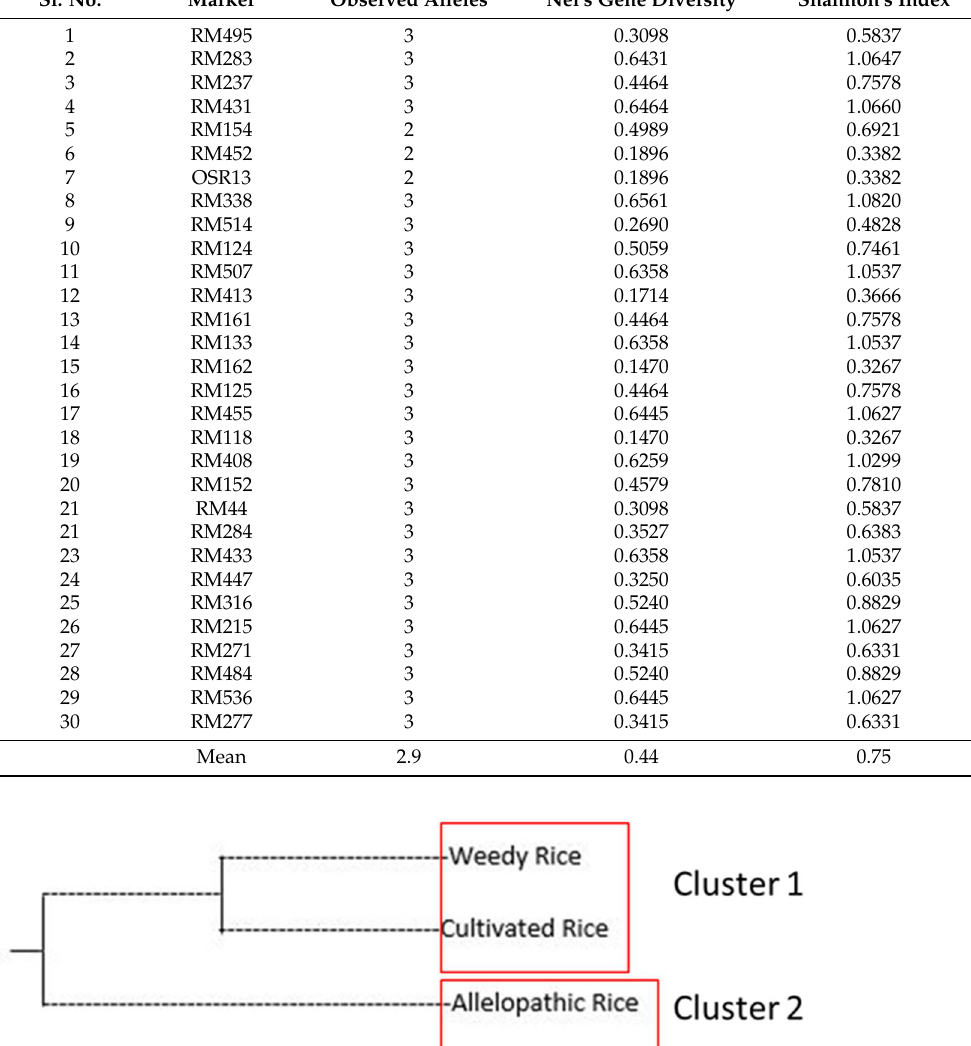
Figure 1. Dendrogram based on Nei’s genetic distance indicating a genetic relationship between weedy rice, cultivated rice, and allelopathic rice. Based on Nei’s genetic distance, weedy rice and cultivated rice clustered together (red box: cluster 1) and allelopathic rice (red box: cluster 2) clustered separately, indicating weedy rice and cultivated rice are more genetically similar as compared to the allelopathic rice used in the current study.